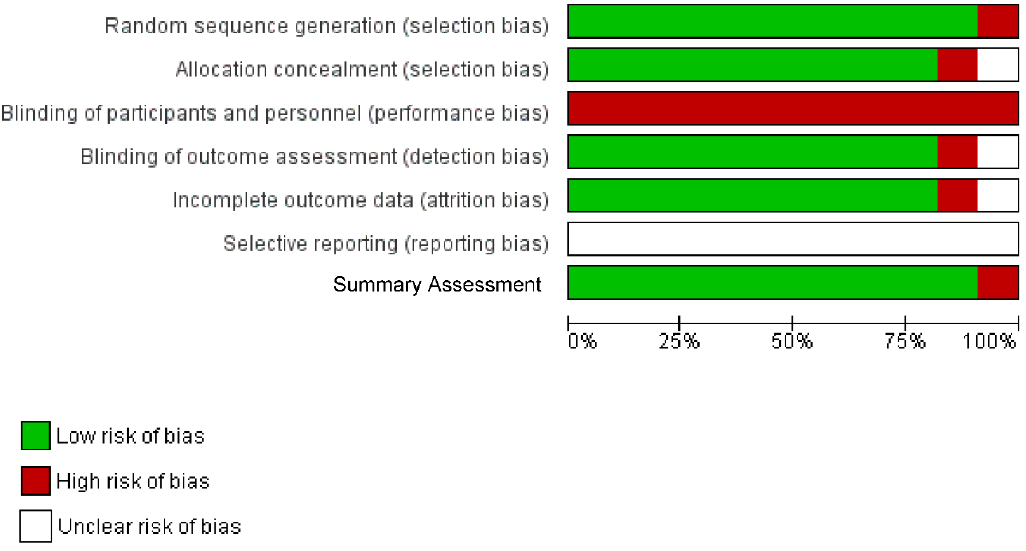
Figure 3. Risk of bias graph: review authors’ judgements about each risk of bias item presented as percentages across all included studies.